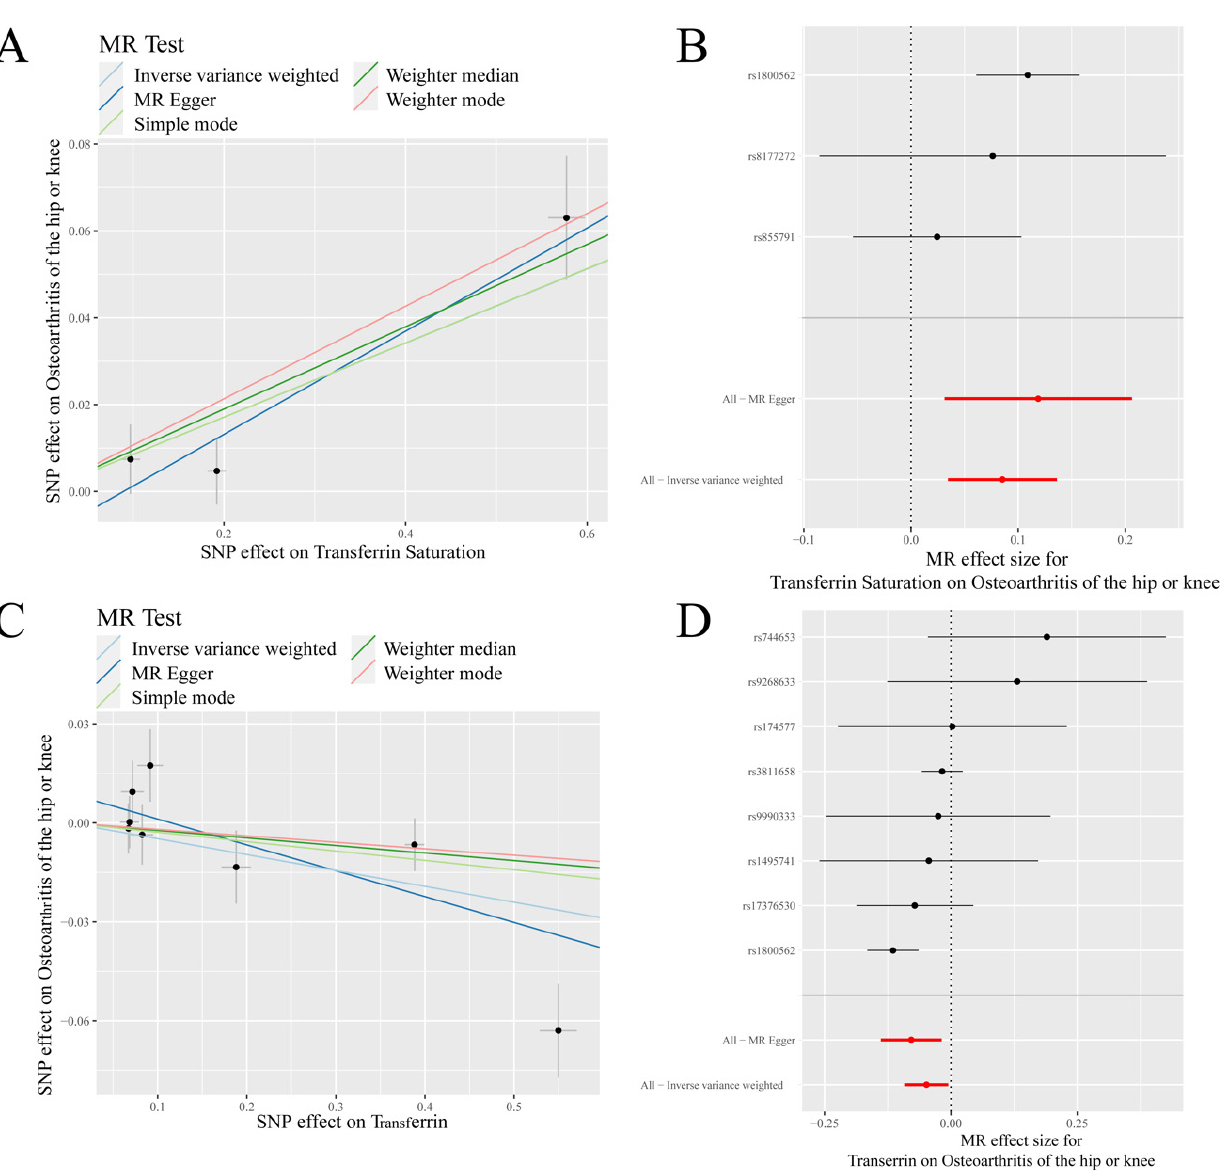
Figure 3. MR results of transferrin saturation, transferrin and knee/hip osteoarthritis (K/HOA): ( A ) scatter plot of genetic correlations of transferrin saturation and K/HOA using different MR methods. The slopes of line represent the causal effect of each method, respectively; ( B ) forest plot of the causal effects of transferrin saturation associated SNPs on K/HOA; ( C ) scatter plot of genetic correlations of transferrin and K/HOA using different MR methods. The slopes of line represent the causal effect of each method, respectively; and ( D ) forrest plot of the causal effects of transferrin associated SNPs on K/HOA. ( B ):The red and black dot/bar indicate the causal estimate of transferrin saturation level on risk of patients with K/HOA. ( D ):The red and black dot/bar indicate the causal estimate of transferrin level on risk of patients with K/HOA.